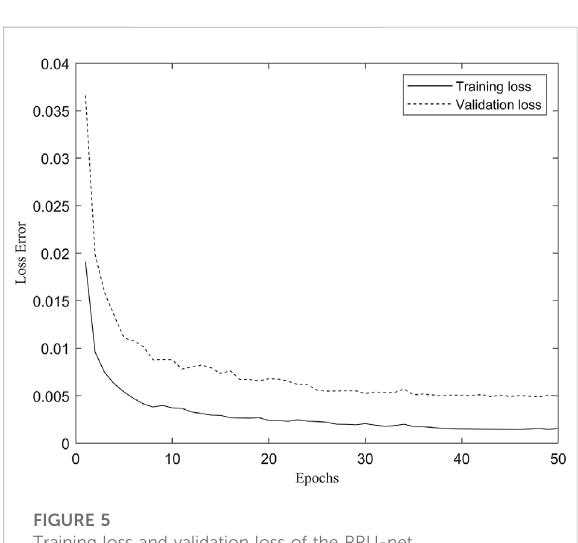
FIGURE 5 Training loss and validation loss of the